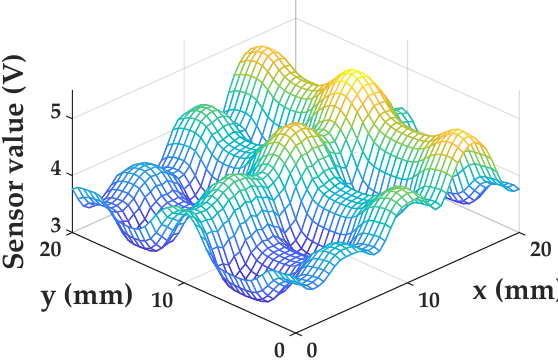
Figure 7. Output value of the single sensor in the range of 20 × 20 mm.